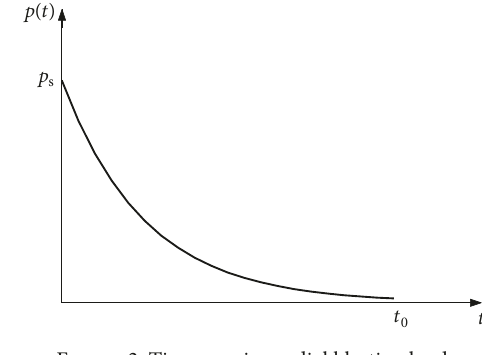
Figure 2: Time-varying radial blasting